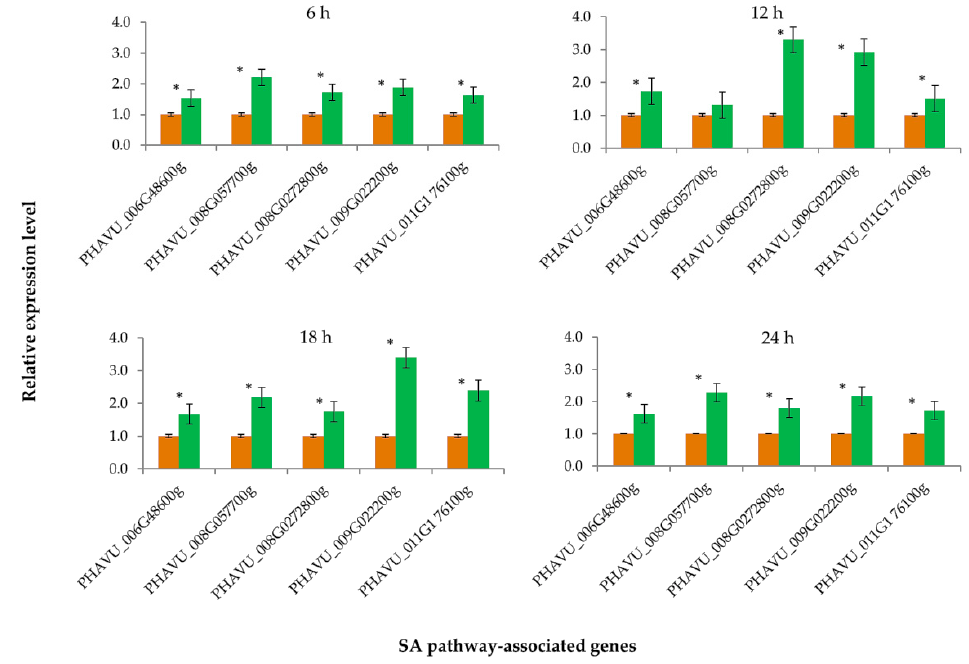
Figure 4. Relative expression levels of SA pathway-associated genes measured at different time intervals after the application of PeBC1 elicitor protein. Green bars indicate the result of PeBC1 elicitor treatments, while orange bars show the result of buffer-treated (control) treatments. Asterisk symbols indicate the significant difference between the treatments for each gene (Student’s t -test, p < 0.05).